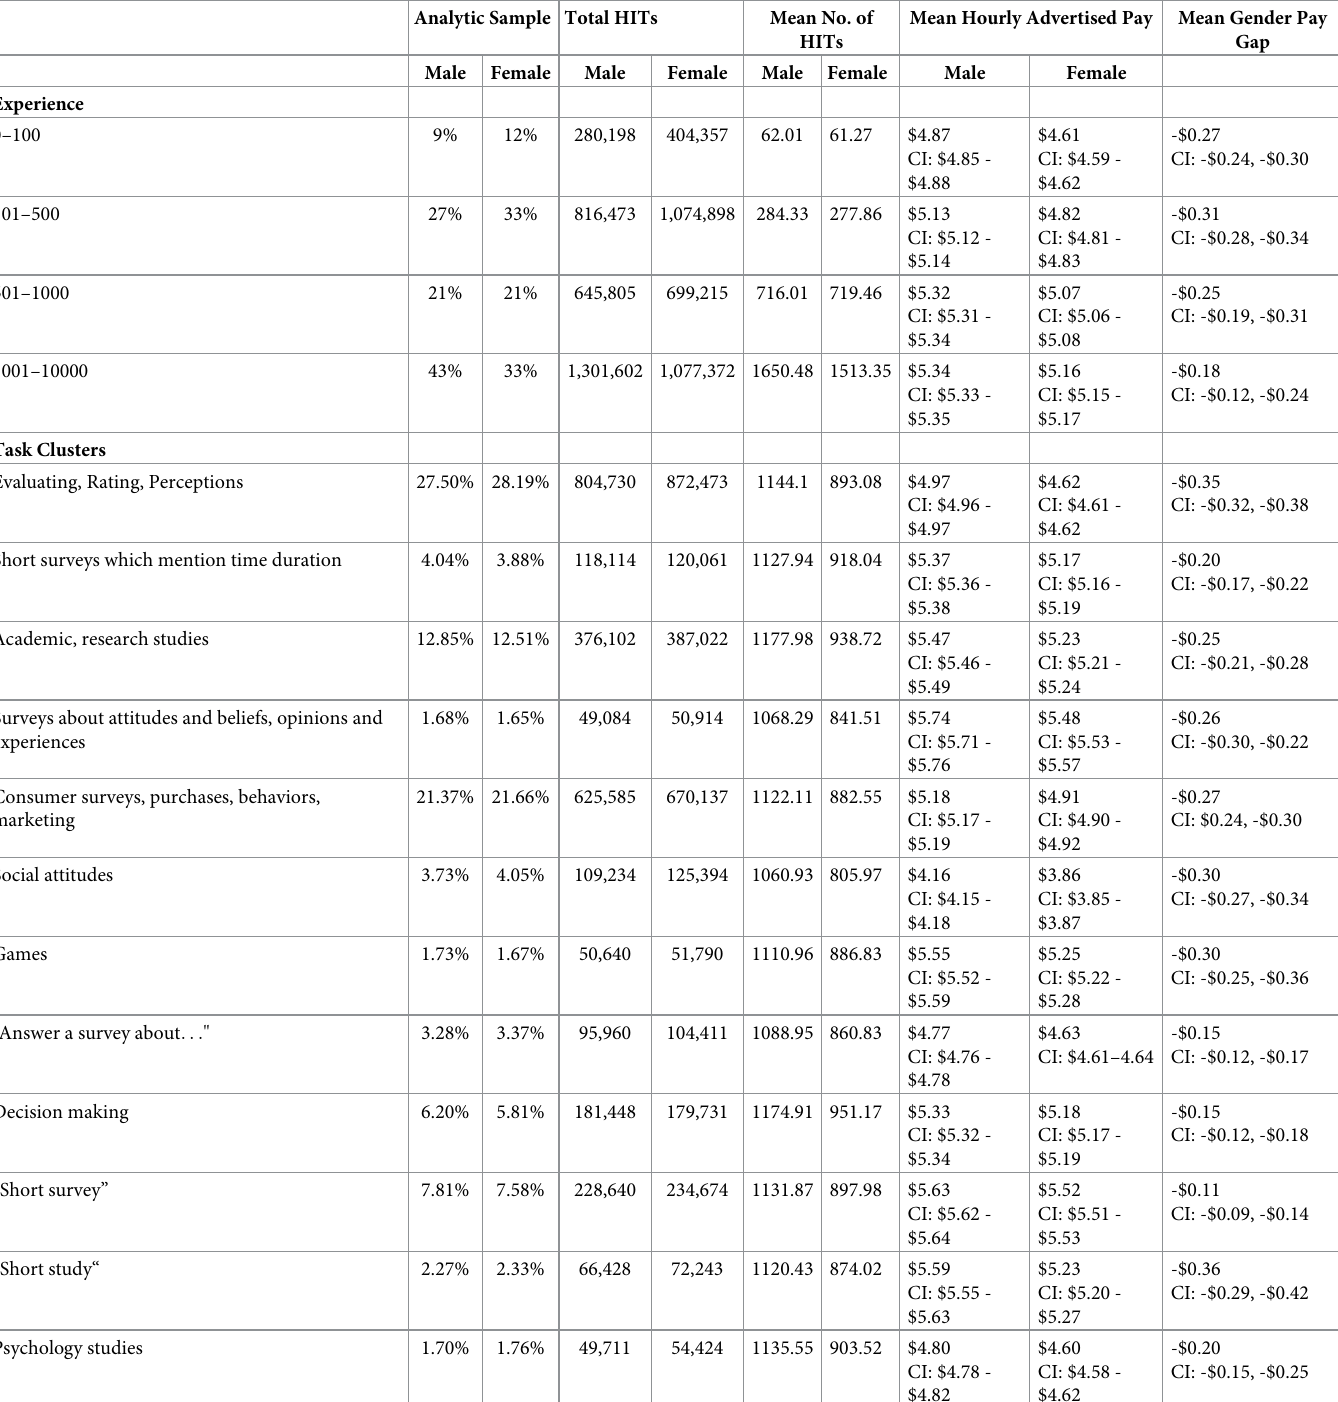
Table 5. Experience level, cluster themes, and average advertised hourly pay for men and women. Analytic Sample Total